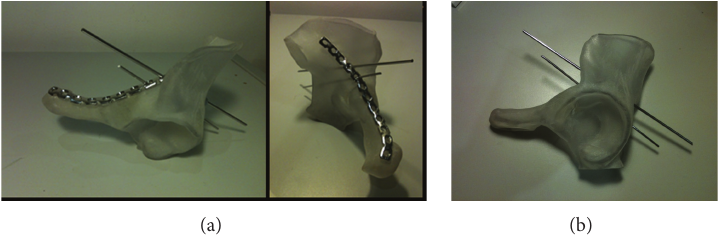
Figure 4: (a) 3D printed model with contoured plate applied. (b) 3D printed model with posterior column trajectories demonstrated.